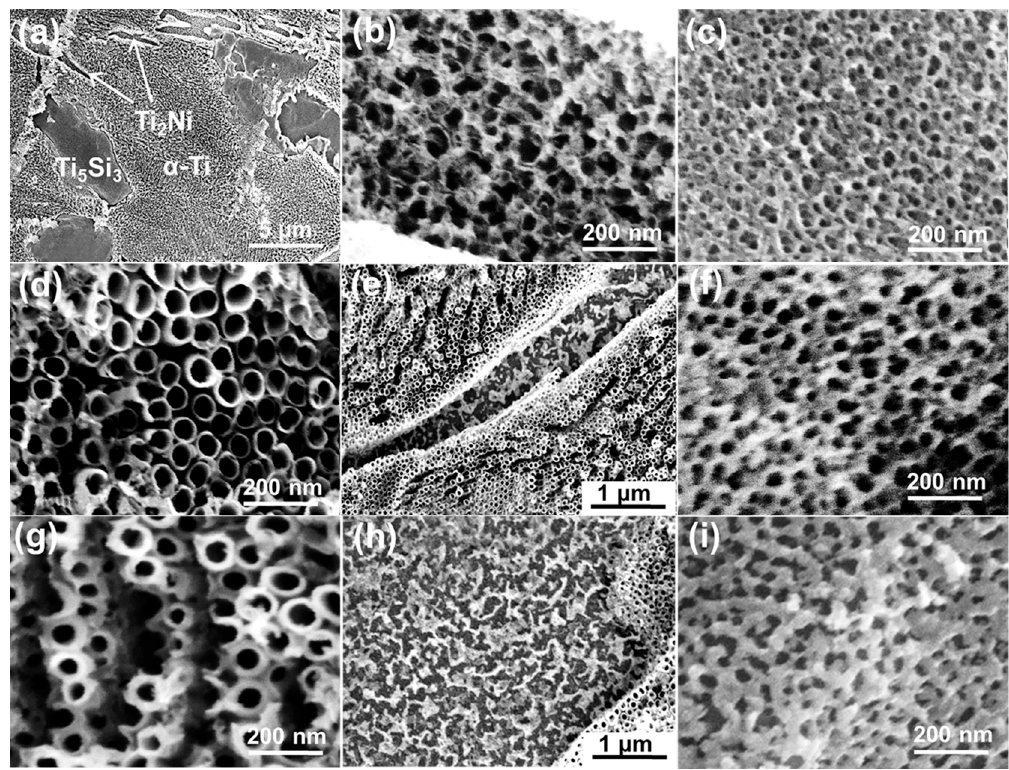
Figure 4. Top-view SEM images of the nanostructures grown in the α -Ti phase, Ti 2 Ni phase and Ti 5 Si 3 phase regions at different potentials. ( a – c ) 30 V, ( d – f ) 40 V, and ( g – i ) 50 V. All anodization experiments were carried out in EL-4 electrolyte for 90 min.